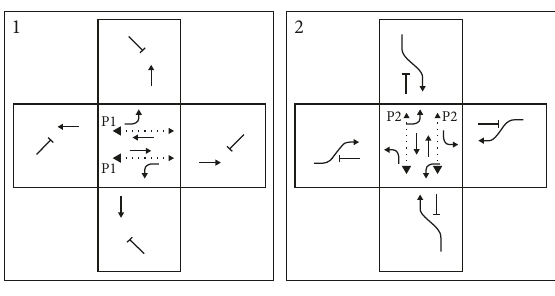
Figure 2: The full CFI signal phasing schemes [12]. Table 1: Advantages and disadvantages of implementing a CFI